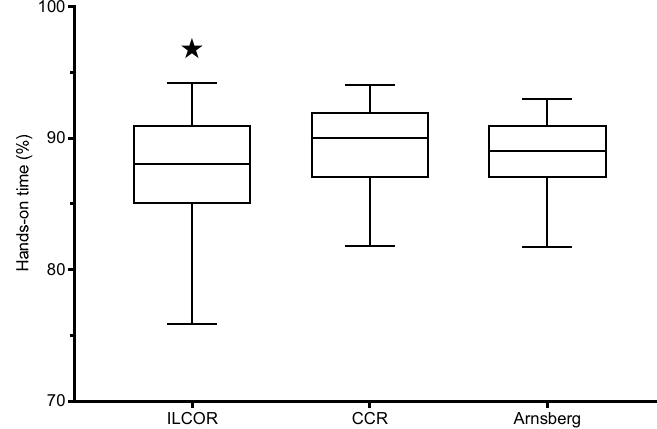
Figure 3. Hands-on times. Box and whiskers plot of the percentages of hands-on times, defined as time of actual chest compressions divided by the total time interval of the study period in the three study groups. Boxes indicate the median and the lower and upper quartiles while the whiskers indicate the 5th and 95th percentile. = p < 0.05 vs. both other groups. These differences, although statistically significant, are not of medical relevance (see discussion).